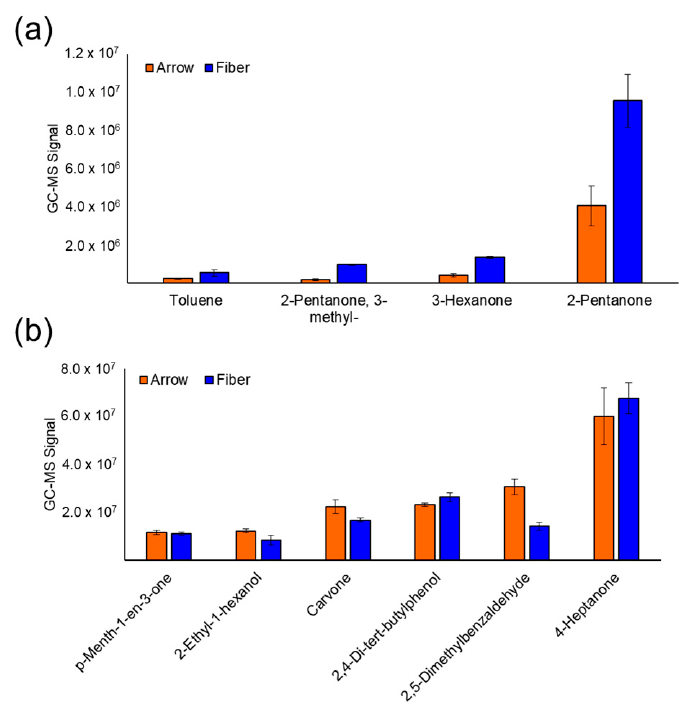
Figure 1. ( a ) Bar charts of GC-MS signals for VOCs with a relatively low molecular weight demon- strate that SPME fibers have higher extraction efficiency toward small analytes. ( b ) GC-MS signals of VOCs with a slightly higher molecular weight shows that the SPME arrow has slightly higher sensitivity for other analytes.